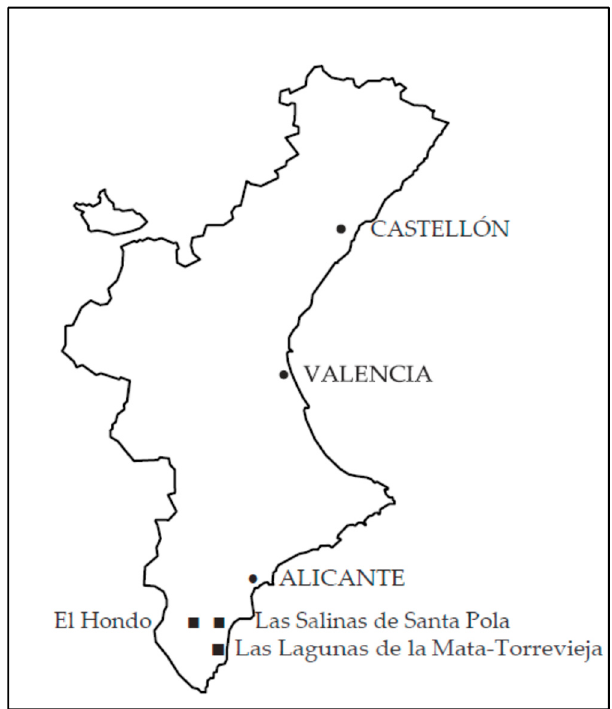
Figure 1. Natural parks located in the southeast part of Alicante province (Valencia Region, Spain).